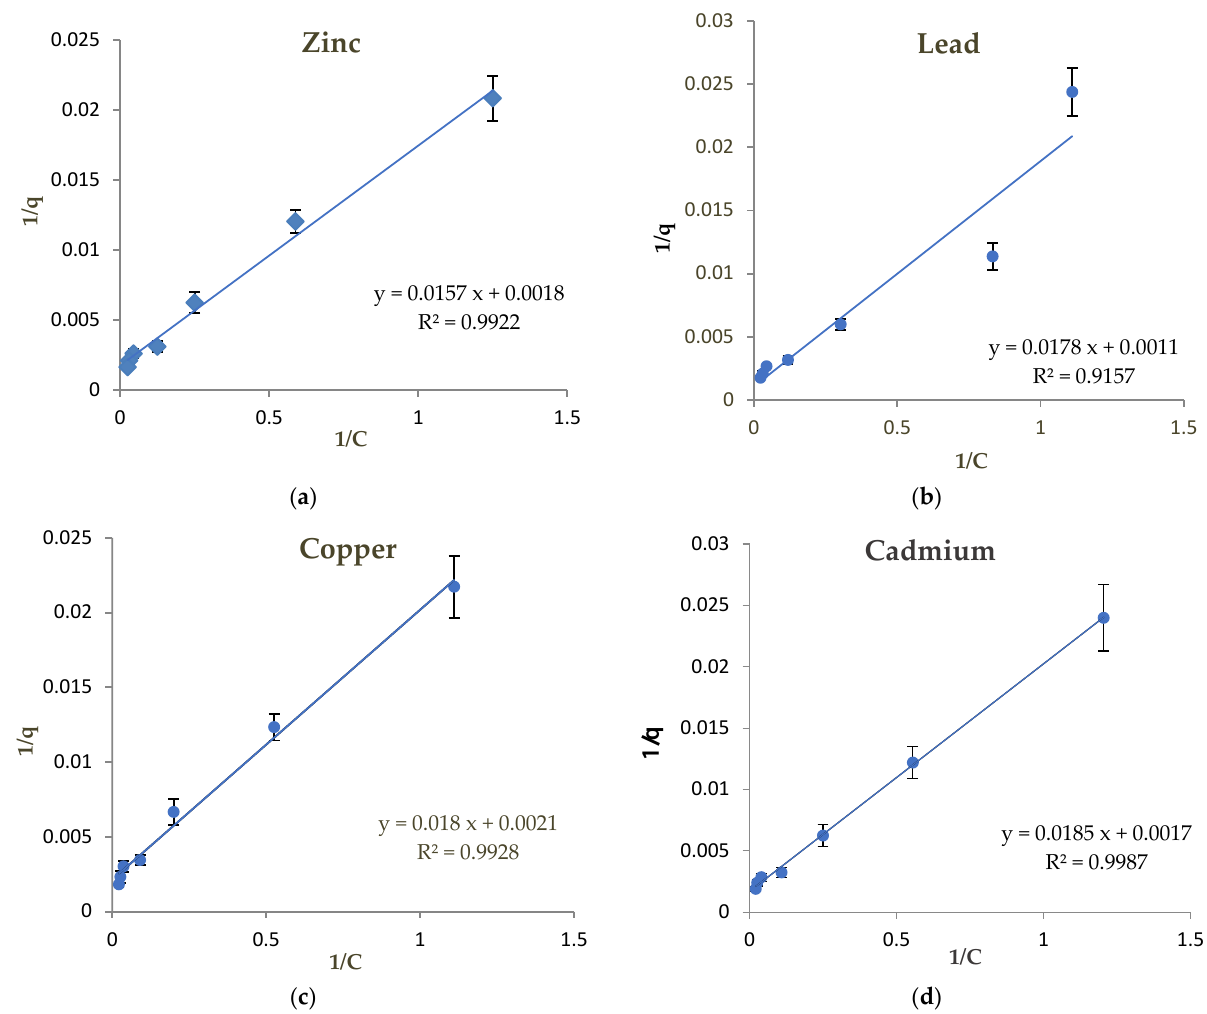
Figure 4. The Langmuir isotherm adsorption of Zn, Pb, Cu, and Cd ( a – d ) in the acidic soil sample.